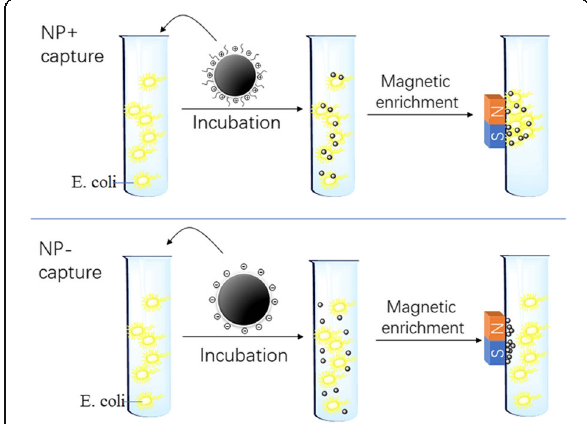
Fig. 3 Illustration of the procedures of bacteria capture. E. coli in suspension are respectively mixed with NP+ and NP − , followed by 10 min incubation. The “ magnetized ” bacteria were attracted onto the wall of the vial by a magnet. After the removal of the remaining solution, bacteria were captured by NPs, washed using PBS, and counted from the number of the bacterial